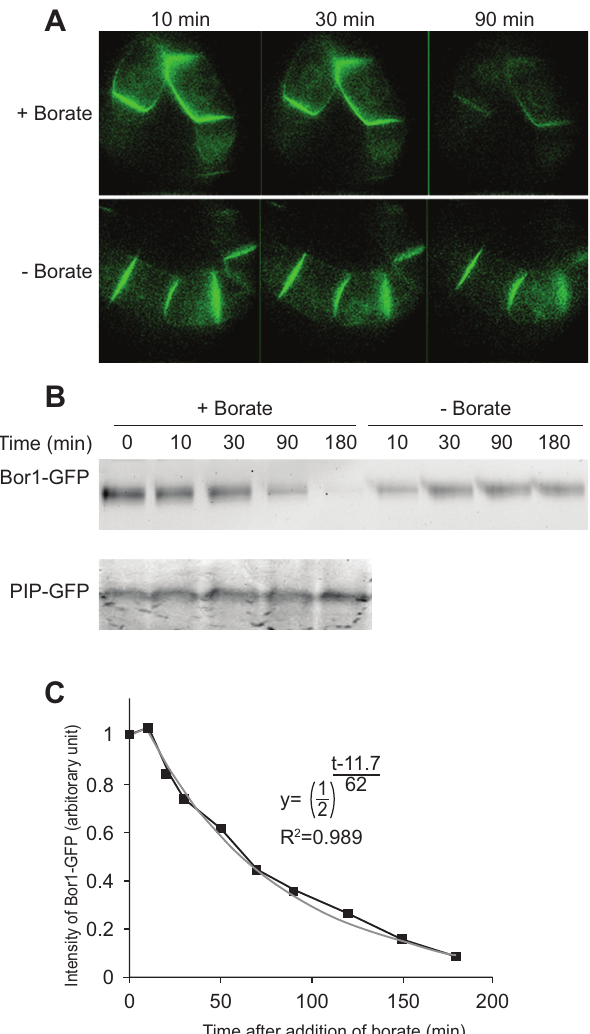
Figure 3. Higher concentrations of borate in the medium induced the degradation of BOR1-GFP. A . Fluorescence images of transformed cells expressing BOR1-GFP in medium containing a high concentration of borate (5 mM; +Borate) and a normal concentration of borate (0.1 mM, -Borate). Images were collected with identical exposure conditions using a confocal microscope. B . Time course of the decrease in BOR1-GFP signal in the presence of borate. Upper gel; cells expressing BOPR1-GFP were incubated in medium with normal or high borate concentrations for the indicated times. Lower gel; cells expressing PIP-GFP were incubated in high borate medium for the indicated times. Fluorescence of GFP fusion proteins after separation by SDS-PAGE was detected by scanning the gel with an image analyzer. A representative gel image is shown. C . Quantification of the degradation of BOR1-GFP. Means of three independent experiments are shown. The gray line is a best-fit curve of the exponential decrease of